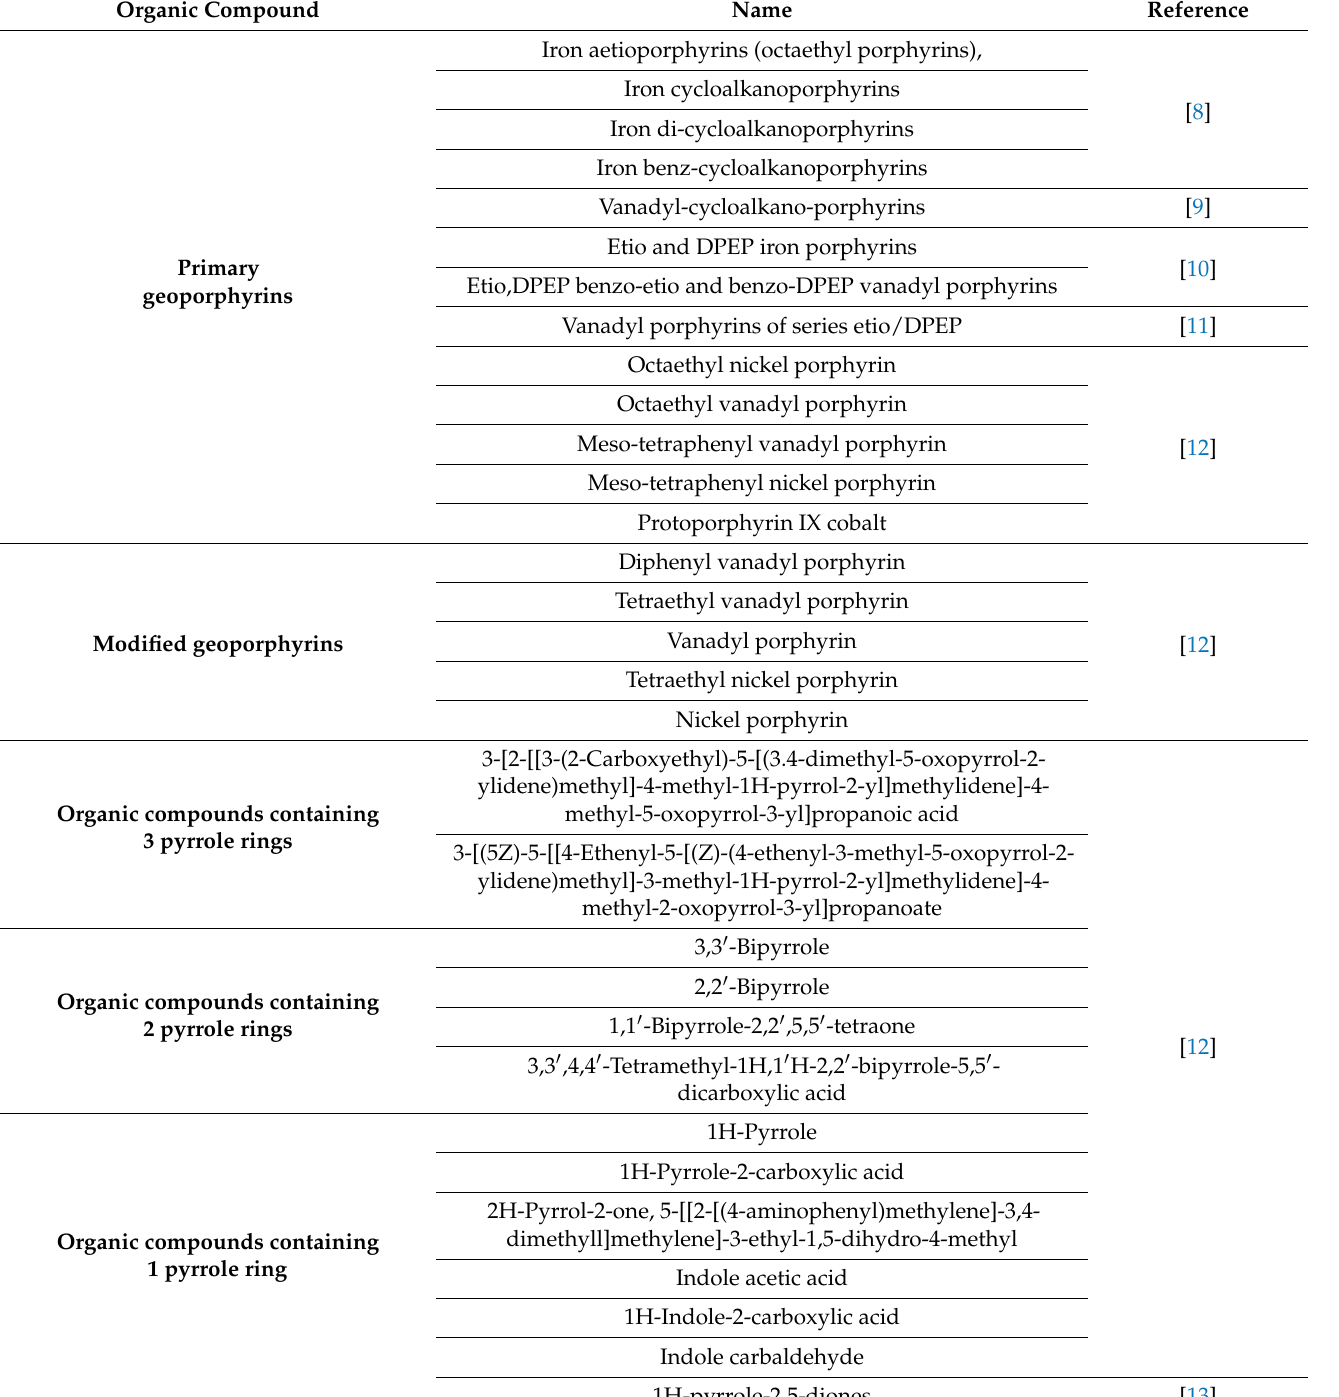
Table 1. Primary and modified geoporphyrins and pyrrole-containing organic compounds detected in the Kupferschiefer shale